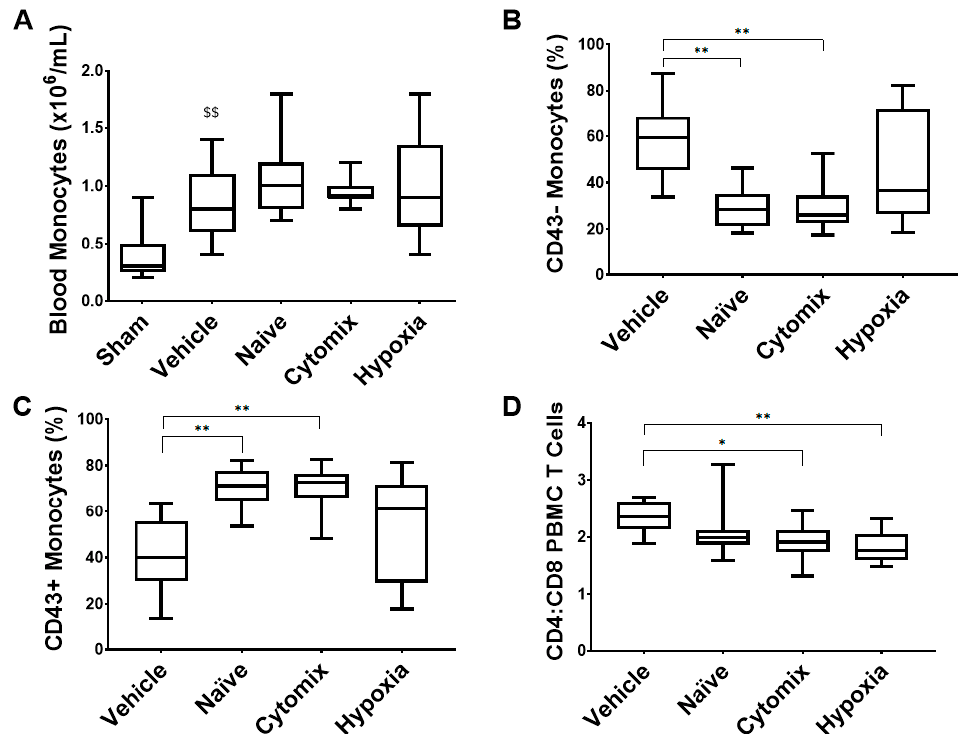
Figure 8. The monocyte fraction increased after treatment with MSCs ( A ), and the % of those that were classical monocytes was decreased by naïve and cytomix MSC treatments ( B ). Nonclassical monocytes were increased in the same groups ( C ). The CD4 to CD8 ratio was significantly decreased with the administration of cytomix- and hypoxia-pretreated MSCs ( D ). PBMC = peripheral blood mononuclear cell; Treg = regulatory T cell. Box plots and whiskers represent the minimum, first quartile, median, third quartile, and maximum. * ,** = p ≤ 0.05, 0.01 with respect to the vehicle con- trol. $$ = p ≤ 0.01 with respect to the sham group. N = 8–12.